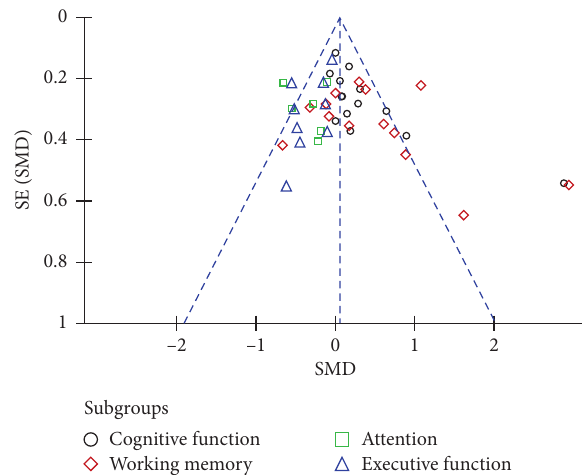
Figure 6: Funnel plot of cognitive benefit of